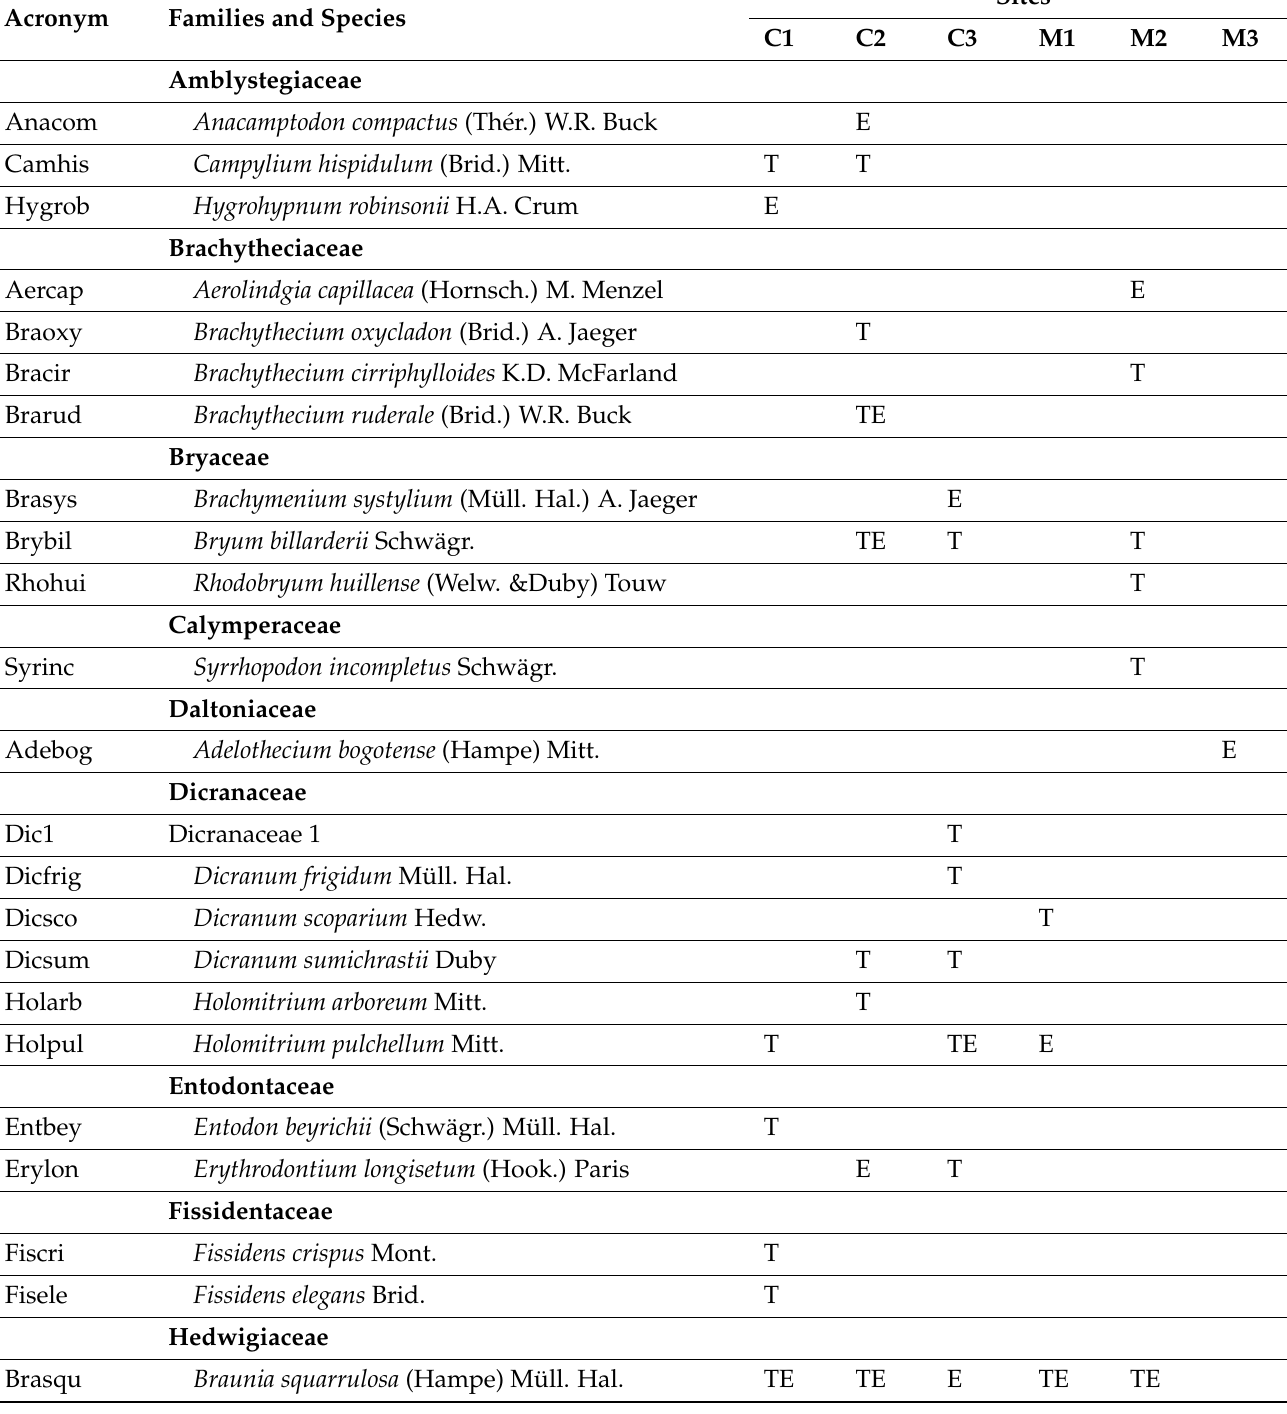
Table A1. Moss species checklist in conserved and managed areas with reduce-impact logging in the Sierra Ju á rez, Oaxaca. Species presence in each site is expressed with a T for terrestrial, E for the epiphytic (collected-on Quercus ), and TE for those collected in both samplings. The acronyms are used in the rank-abundance